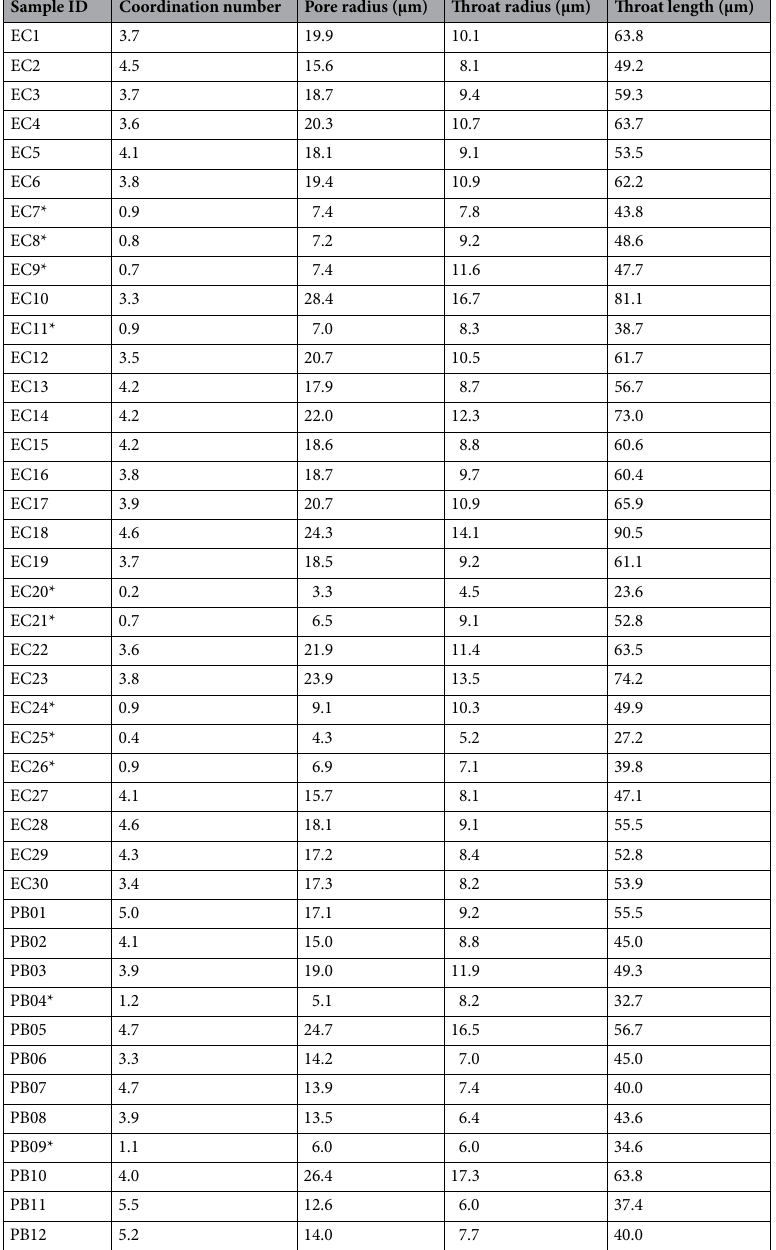
Table 2. Mean measurements of coordination number, pore radius, throat radius and throat length from pore network models of each English Channel and Porcupine Basin samples. *Indicates measurements made on total porosity due to no connected porosity. Measurements from the other sample suites are available in their respective publications 18